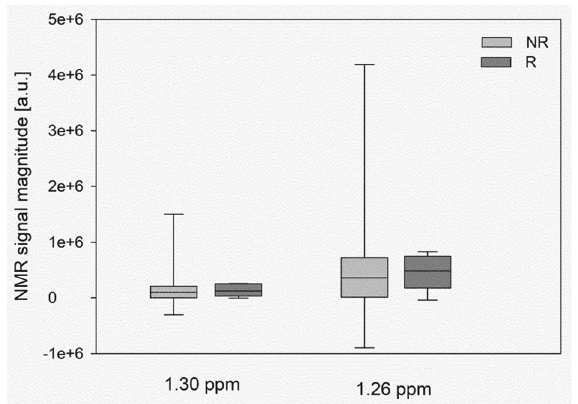
Figure 3. Mean ± SD signal magnitude changes of the most changed after exercise training fatty acids NMR at 1.26 ppm and 1.30 ppm. NR non-responders, R responder patients, FA fatty acids, SD standard deviation, NMR nuclear magnetic